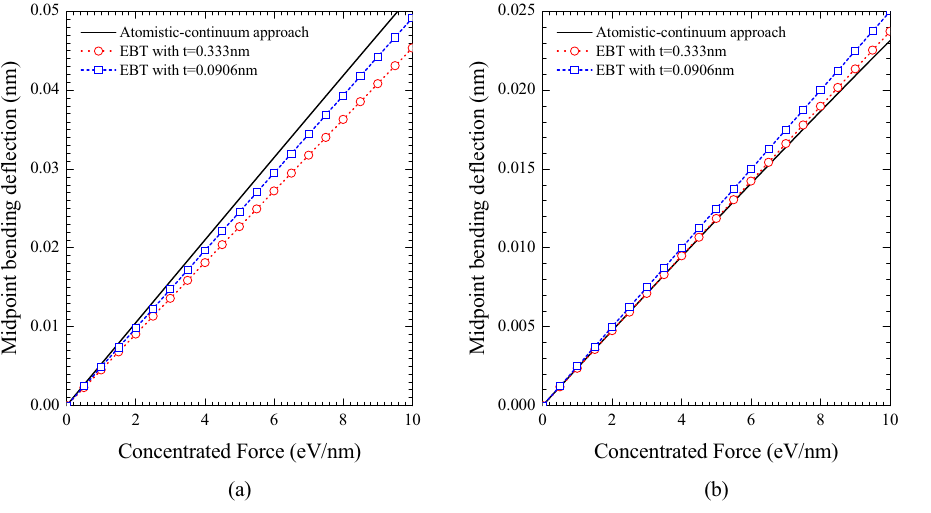
Figure 5: The maximum bending de fl ection of 10 nm long ( 8, 8 ) ( a ) and ( 10, 10 ) ( b ) BNNTs with clamped constraint versus external lateral force.